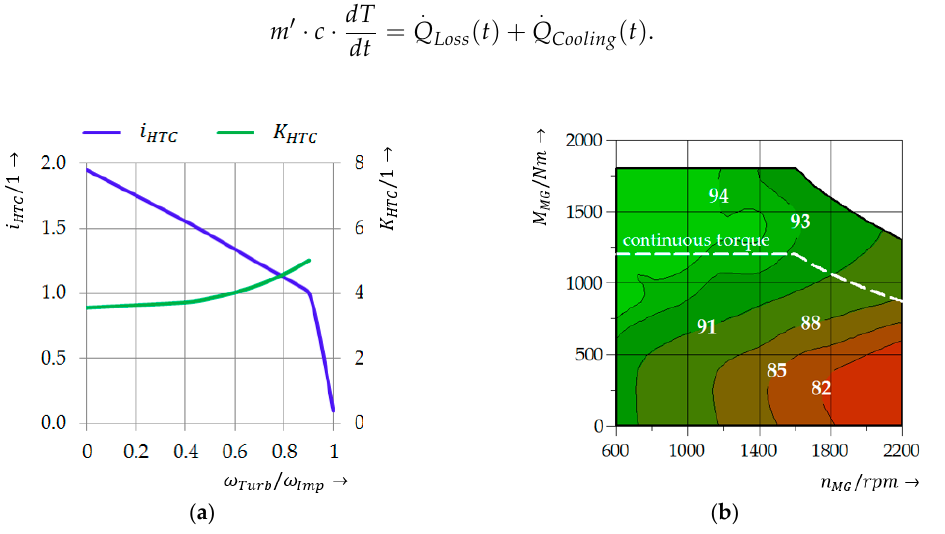
Figure 5. ( a ) Torque converter torque ratio i HTC and capacity factor K HTC over the speed ratio; ( b ) MG efficiency